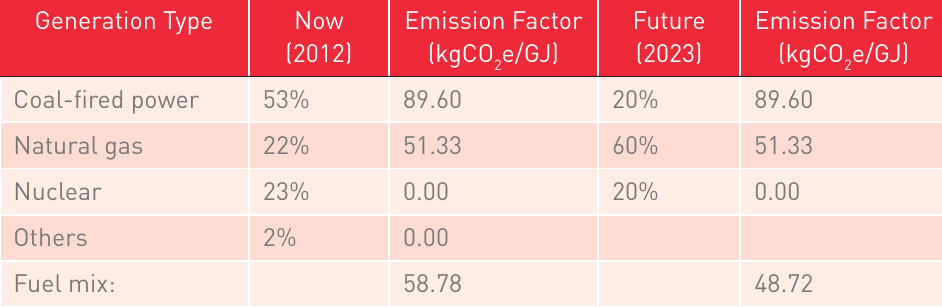
Hong Kong electricity generation mix Generation